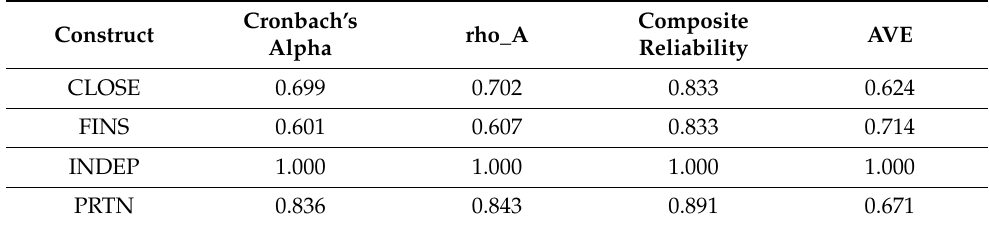
Table 4. Construct reliability and validity.